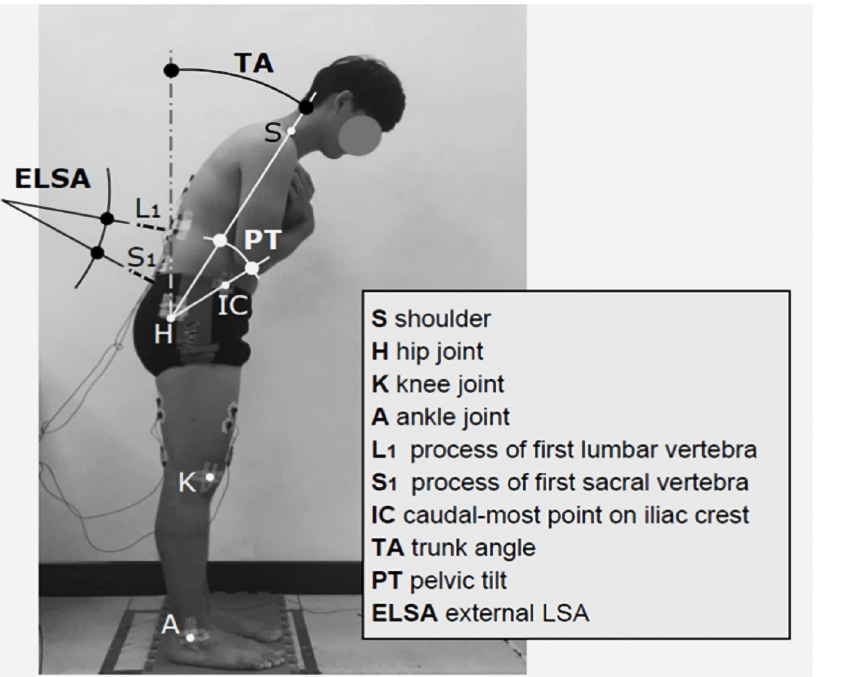
Fig 2. Schematic of testing posture, body angles, and marker and sticker